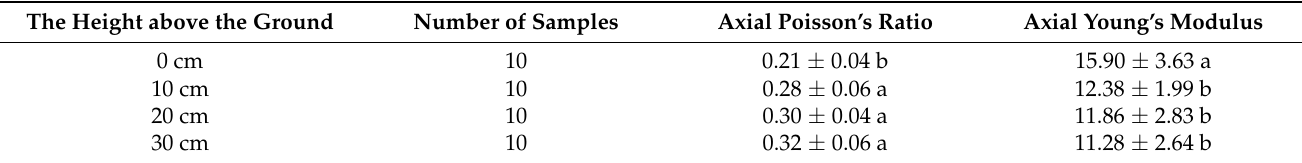
Table 4. The Turkey multiple comparison test.